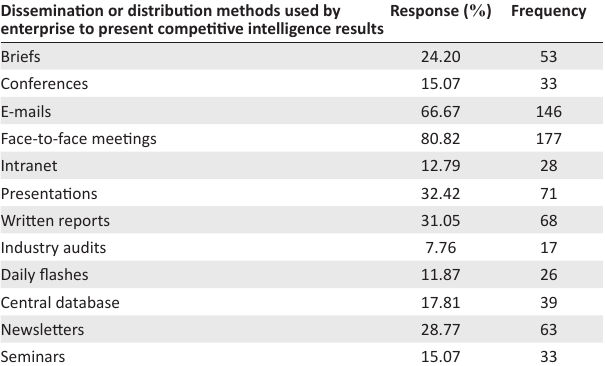
Table 15 indicates the frequency of response of management support of CI practice in the property sector.